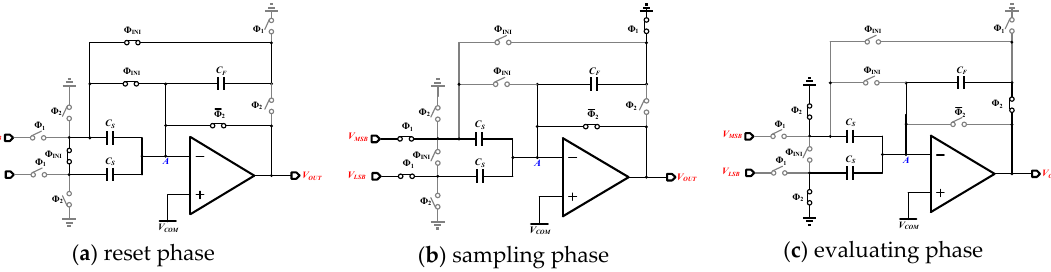
Figure 4. Operation states of our proposed buffer-reused two-stage DAC according to the operation phases: ( a ) the reset phase, ( b ) the sampling phase and ( c ) the evaluation phase.